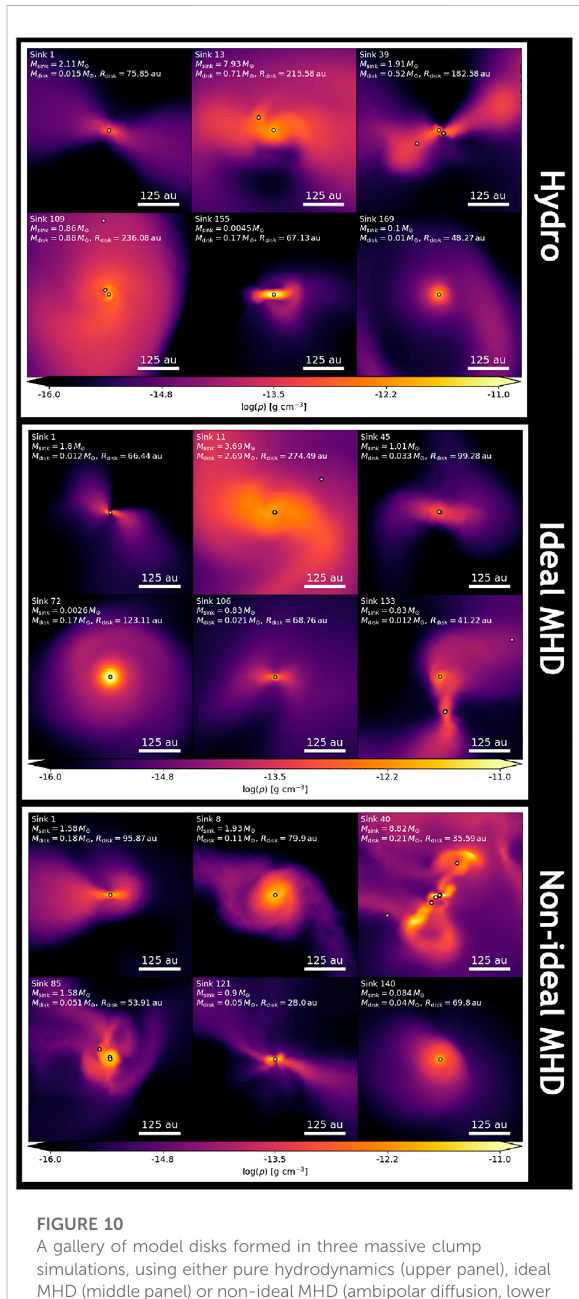
FIGURE 10 A gallery of model disks formed in three massive clump simulations, using either pure hydrodynamics (upper panel), ideal MHD (middle panel) or non-ideal MHD (ambipolar diffusion, lower panel), from Lebreuilly et al. (2021). Hydrodynamical disks tend to be bigger, while ideal MHD ones smaller than when ambipolar diffusion is